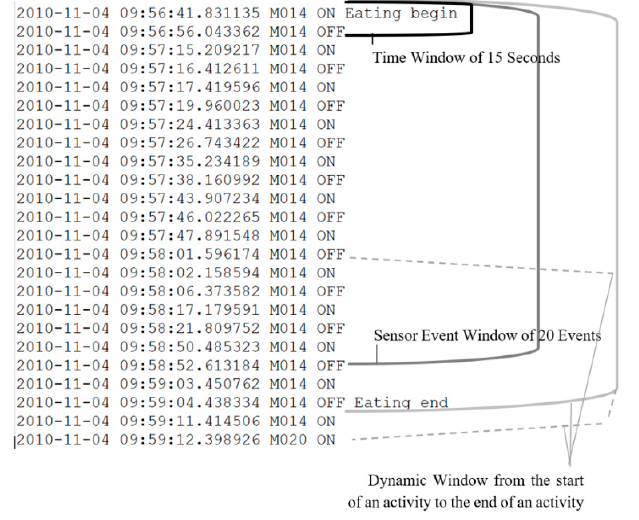
Figure 2. Each of the window approaches represented on a raw snippet of the Aruba Dataset. A Time Window of 15 s is represented by the black brace. A Sensor Event Window of 20 sensor events is represented by the dark grey brace. A Dynamic Window containing the best fitting sensor group is represented by the dashed line, as the DW changes based on the activity being